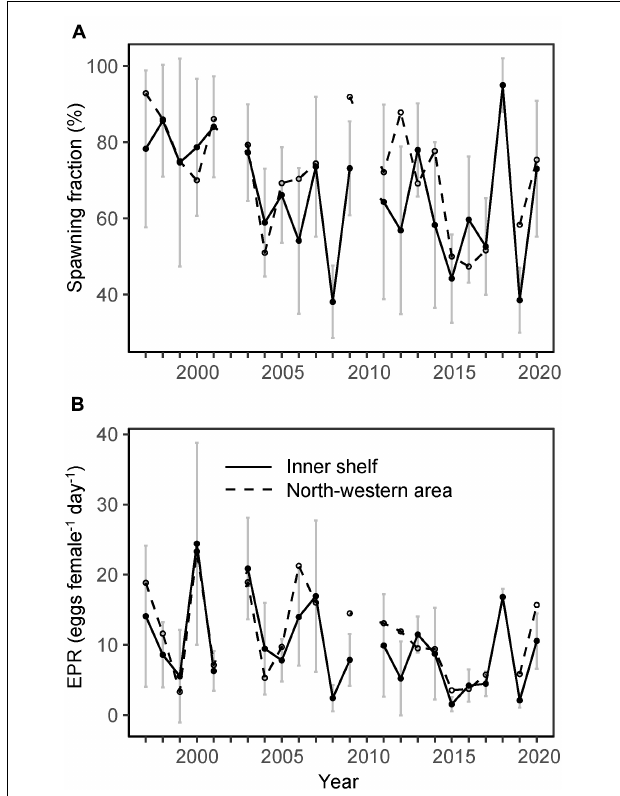
FIGURE 4 | Mean C. finmarchicus (A) fraction of spawning females and (B) individual egg production rates (eggs female − 1 day − 1 ) on the inner Faroe shelf (solid black line, domain defined by the 100 m depth contour) and in the north-western area (dashed black line, area outlined in Figures 2C,D ) in late April 1997–2020. Vertical lines show spatial standard deviation for the inner shelf.